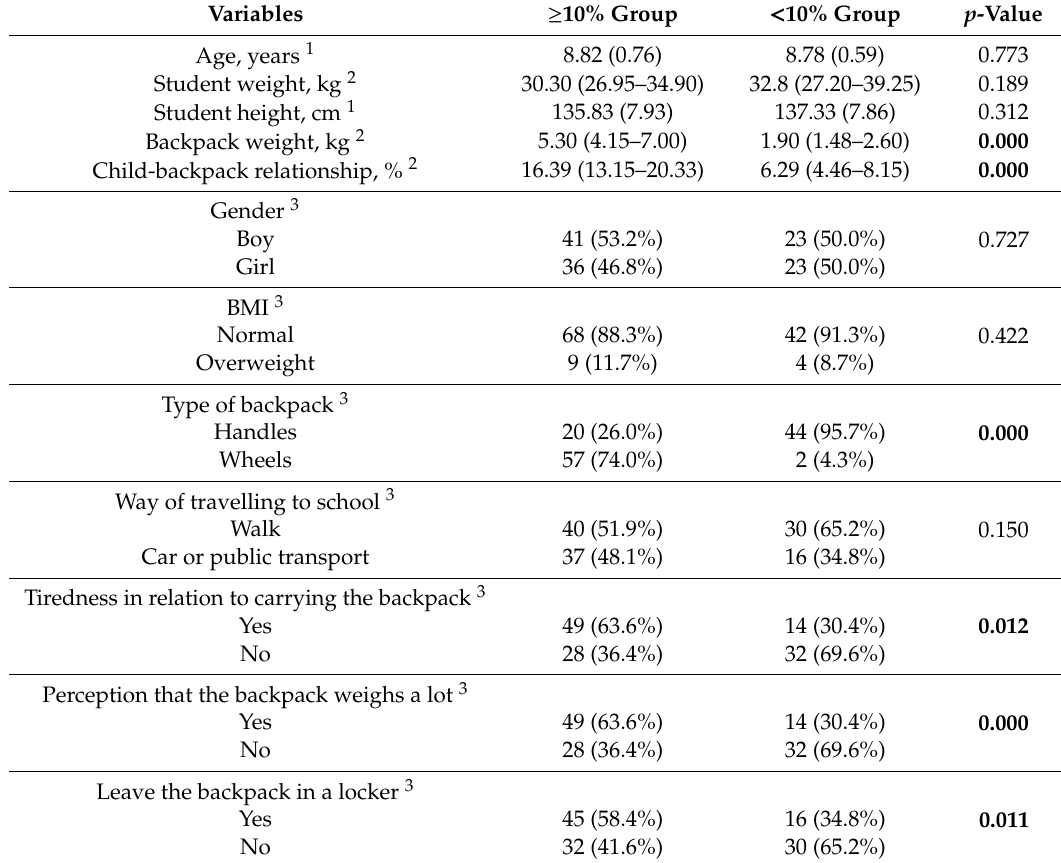
Table 1. Characteristics of the population and the carrying of